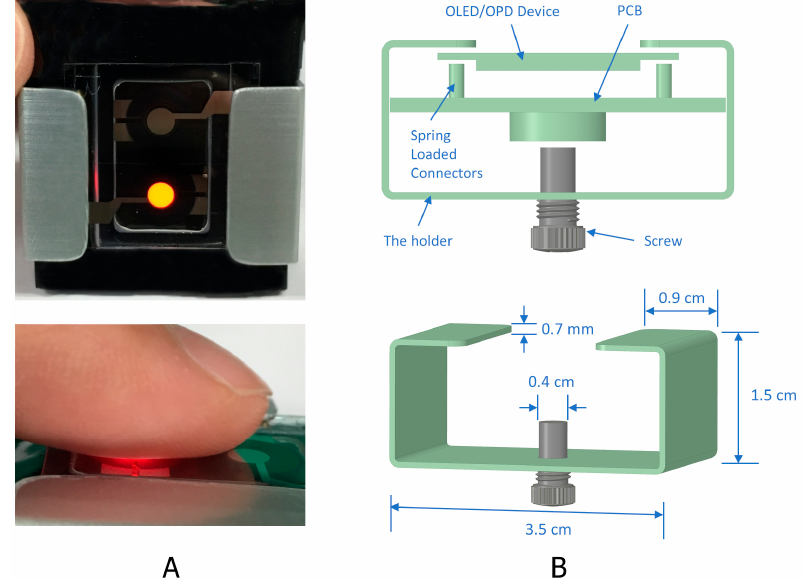
Figure 7. ( A ) The proposed portable pulse meter prototype for wireless monitoring via Bluetooth low energy (BLE). ( B ) The device holder, that used to fix the parts together, and its dimensions.